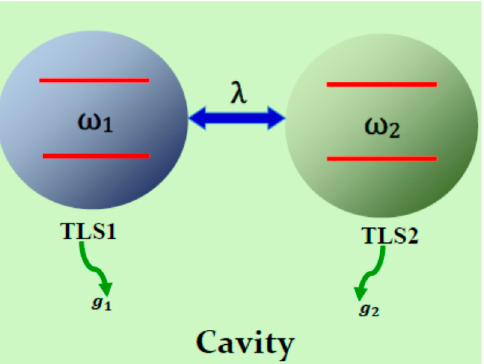
Figure 1. A diagram illustrating our system. TLS1 and TLS2 are both placed inside one cavity. A donor (with resonant frequency ω 1 ) and an acceptor (with resonant frequency ω 2 ) are modeled by two-level atoms with strong dipole-dipole interaction. Realistic quantum control almost necessarily implies engagement of continuous variable interaction of TLSs having a finite number of states with a “large” system with a continuous quantum state. The coupling strength that provides the physical mechanism for coherent energy transfer and entanglement generation is considered in the context of the time-dependent coupling effect G ( t ) .